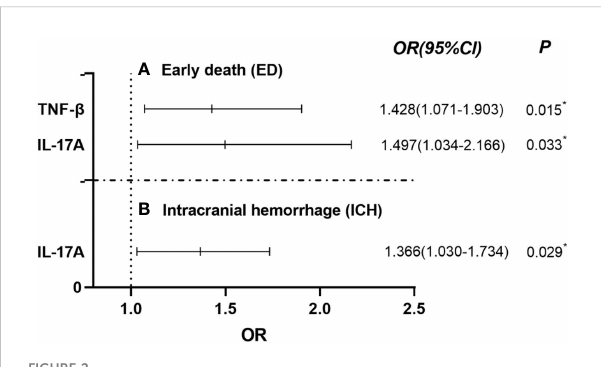
FIGURE 2 Using Binary Logistic Regression, statistically signi fi cant cytokines were screened out by univariate analysis and further multivariate analysis was used to test showed that TNF- b and IL-17A were independent risk factors for ED in APL patients [ (A) Early death (ED)]. In addition, IL-17A was also an independent risk factors for ICH in APL [ (B) Intracranial hemaorrhage (ICH)]. *P <